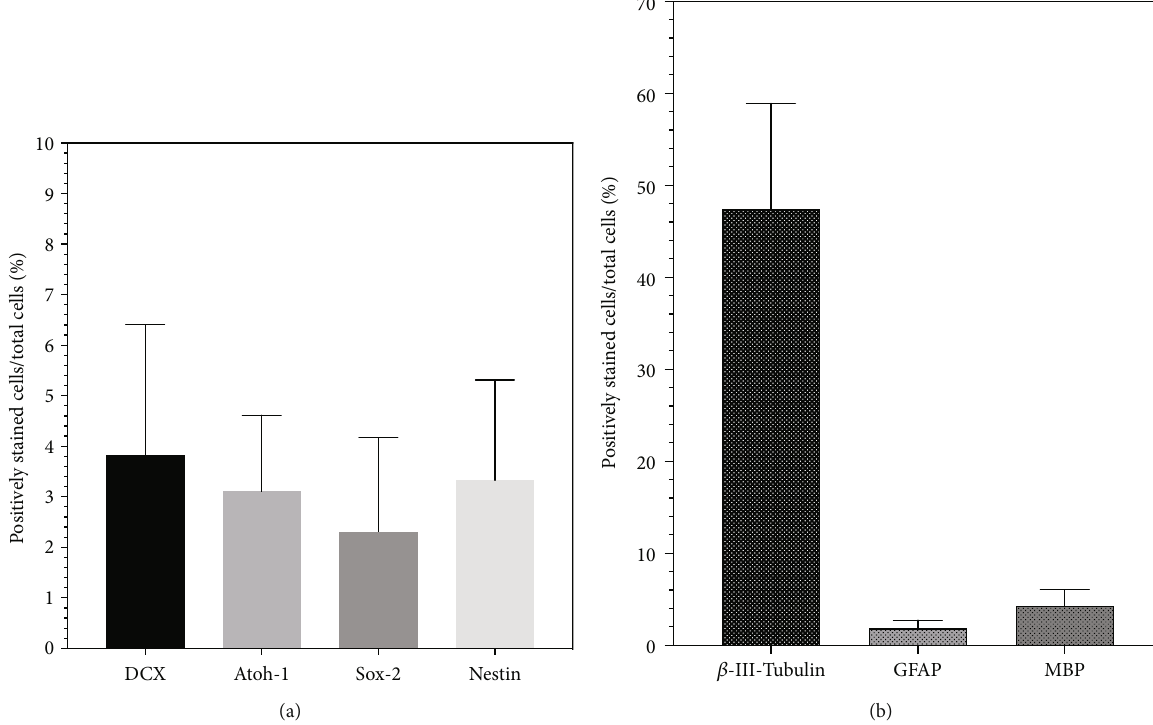
Figure 7: Results of the immunocytochemical analysis of the plated single cells of IC NSC cultures from PND6 rats. The proportions of positively stained cells in relation to the total number of cells on coverslips were evaluated. The boxplots show mean and SEM. (a) Cell proportions that are positive for the analyzed progenitor cell markers after 24 hours on glass coverslips in NSC medium (b) Di ff erentiated cells after 6 days on glass coverslips in DIF medium. Di ff erentiated cell types could be identi fi ed morphologically and by immunohistochemical markers of the neuroectodermal lineage. β -III-Tubulin stains cells that di ff erentiate into the neuronal lineage, GFAP stains those that di ff erentiate into the astroglial lineage, and MBP stains those that di ff erentiate into the oligodendrocyte